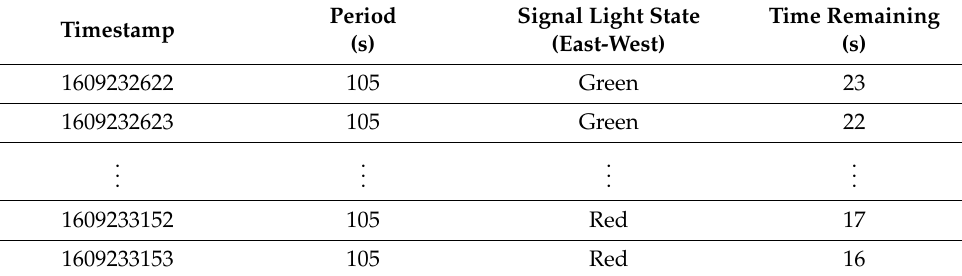
Table 5. Signal light data states at the